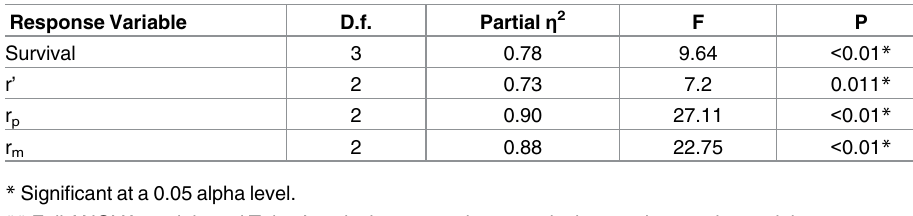
Table 1. Summary of partial ANOVA results for the explanatory variable of parasite dosage and some response variables ** .